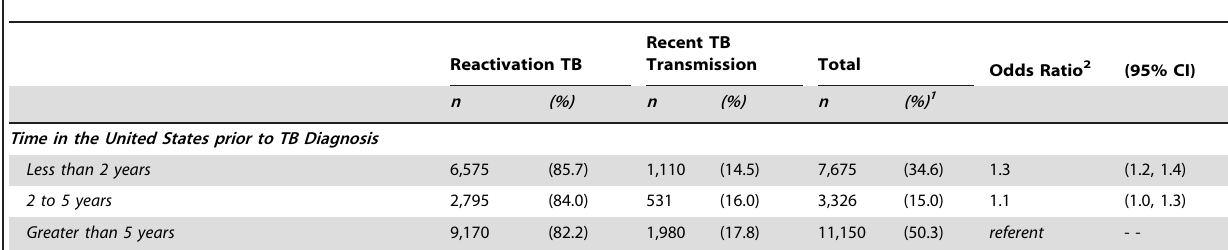
Table 4. Proportion of reactivation TB among foreign-born TB cases by time in the U.S. prior to TB diagnosis, United States 2005–